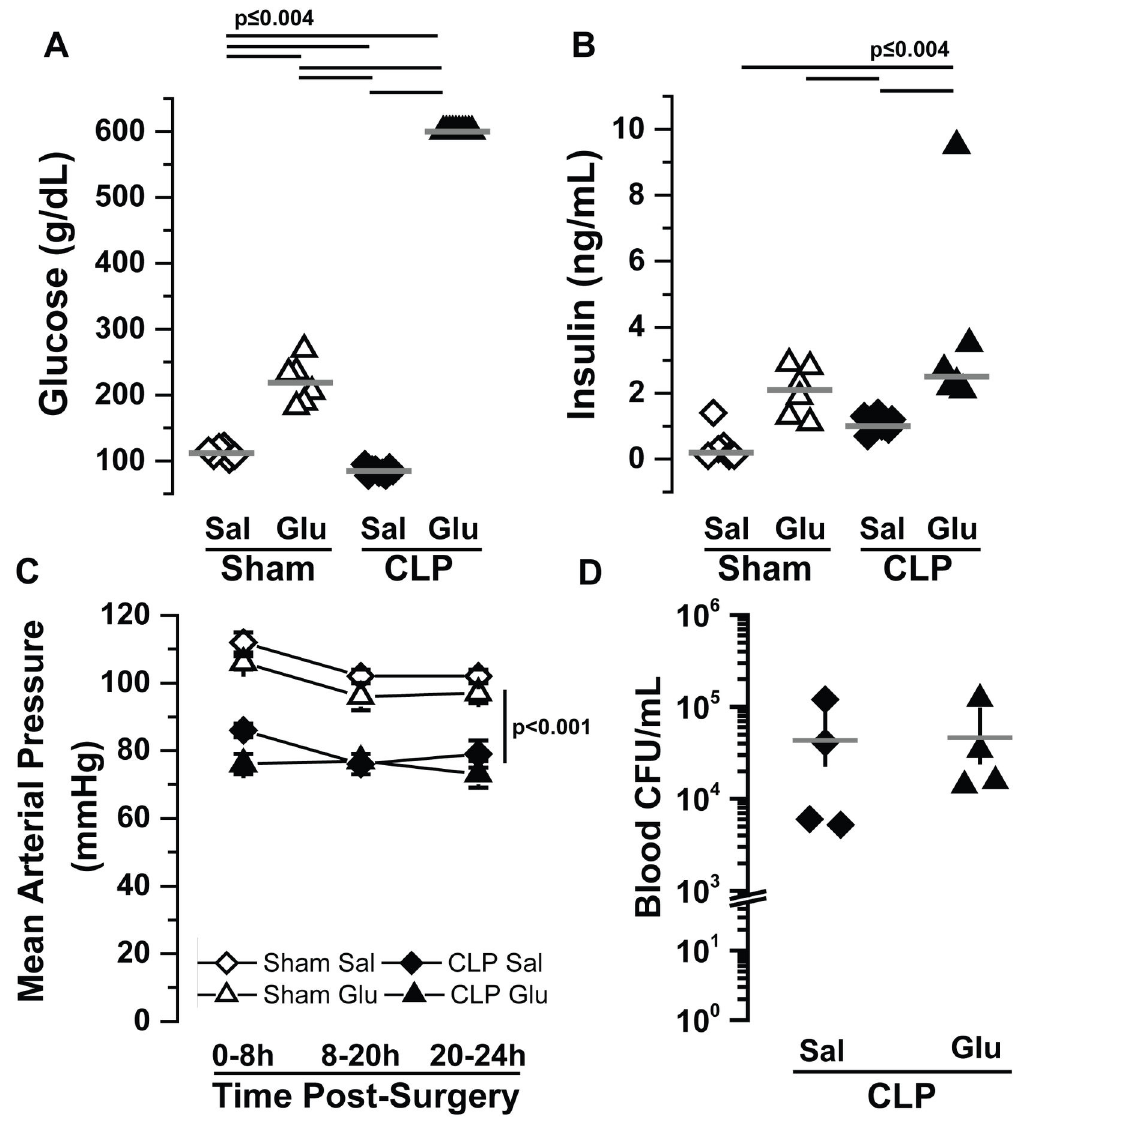
Figure 6. Metabolic and hemodynamic profiles after cecal ligation and puncture. Scatter plot of individual data sets for (A) 18 hr blood glucose, (B) 18 hr plasma insulin and (C) mean arterial blood pressure for mice that have undergone either CLP or sham surgery and infused with iv saline (Sal) or glucose (Glu) at 100 µL/hr for 24 hrs post-operatively (Sham Sal, open diamonds, Sham Glu, open triangles, CLP Sal, closed diamonds, or CLP Glu, closed triangles). Mean arterial blood pressure was averaged over consecutive periods of 8 hrs, 12 hrs, and 4 hrs. Panel D depicts bacterial colony forming units (CFU) in blood extracted from mice 24 hrs after CLP and subject to post-operative saline or glucose infusion. Statistical differences were determined by Kruskal-Wallis test with differences between individual means determined by post-hoc Wilcoxon rank-sum tests corrected for multiple comparisons using the Bonferroni